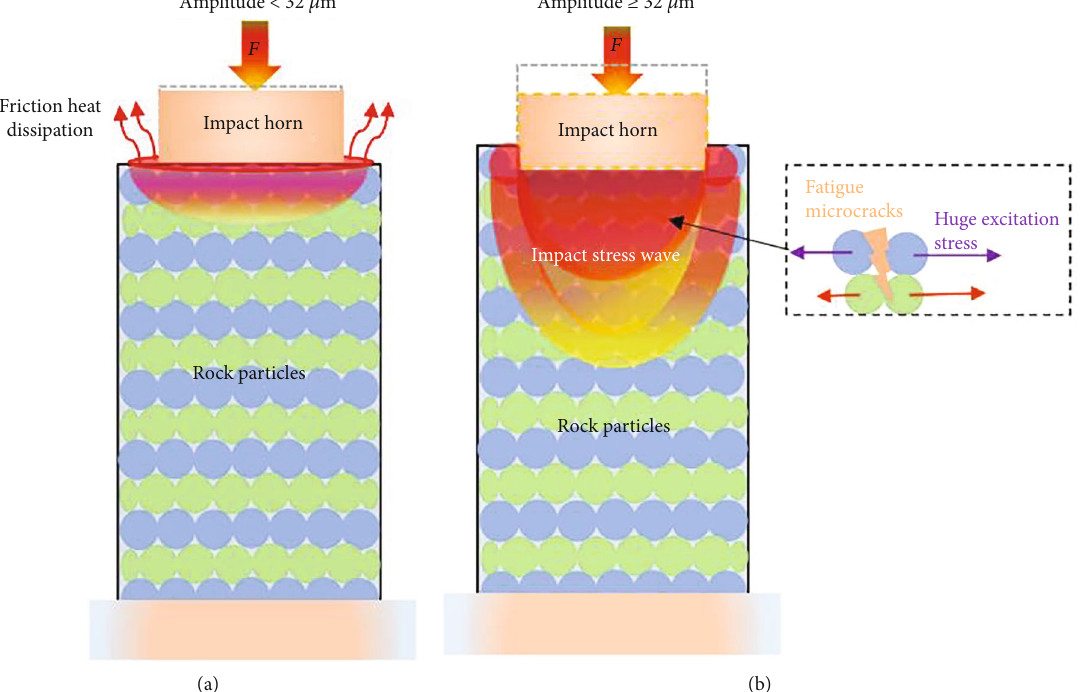
Figure 7: E ff ect of amplitude on the propagation of load stress wave: (a) amplitude < 32 μ m ; (b) amplitude ≥ 32 μ m